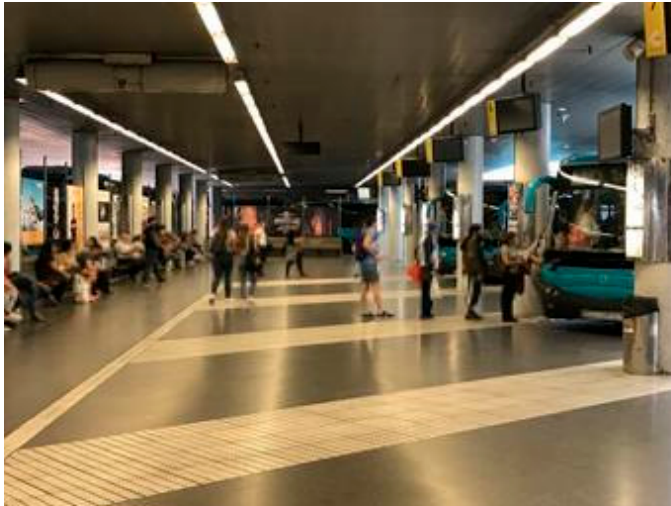
Figure 3. View of the area to be used as a testbed.